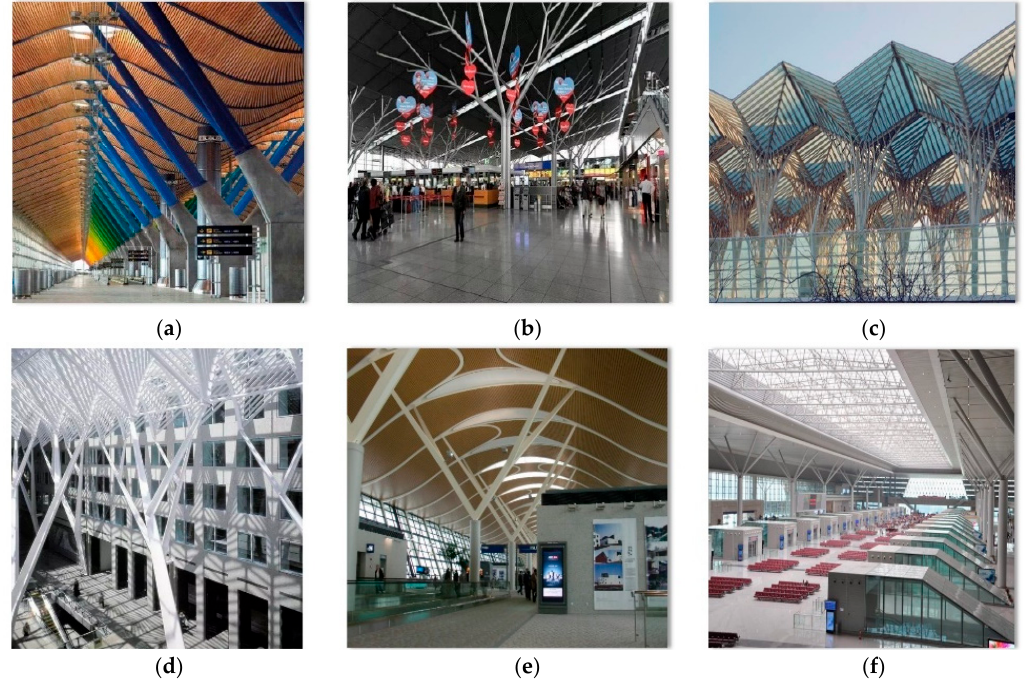
Figure 1. ( a ) New Delhi Airport Terminal T4; ( b ) Stuttgart Airport Terminal; ( c ) Lisbon Orient Station; ( d ) Allen Lambert Promenade; ( e ) Shanghai Pudong Airport T2 Terminal; ( f ) Xi’an North High-Speed Railway Station. (Images by Wen-Feng DU).